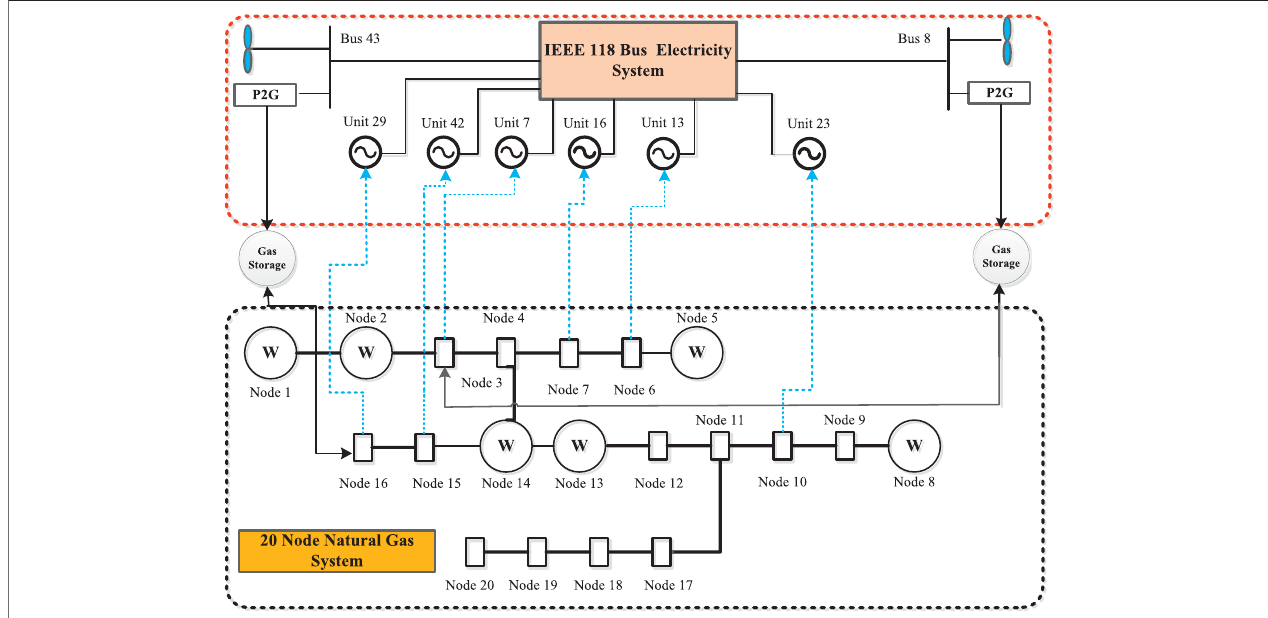
FIGURE 7 | Structure of integrated IEEE 118-bus power system and 20-node natural gas system.